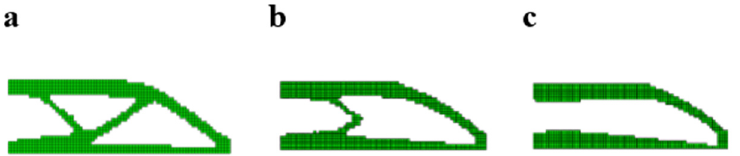
Figure 15. Optimization results for different stiffness of the base material ( a ) 2500 MPa, ( b ) 7500 MPa, ( c ) 12,500 MPa. Table 1. Comparison of the performed optimizations. As reference a cantilever beam made of sFRP with an E (cid:2870) = 12,500 MPa ( a ) is used here. A significant increase in stiffness can be achieved by inserting a continuous fiber reinforcement ( E (cid:2869)‖ = 100,000 MPa , E (cid:2869)(cid:2884) = 10,000 MPa ). For ( b ) the reinforcement structure was optimized using a BESO algorithm for isotropic materials. Variant ( c ) shows the result when the anisotropy of the fiber reinforcement is taken into account. In ( d ), both the anisotropy of the fiber reinforcement and the stiffness of the injection molding material were included in the optimization. This allows to increase the stiffness even further for the same amount of material.